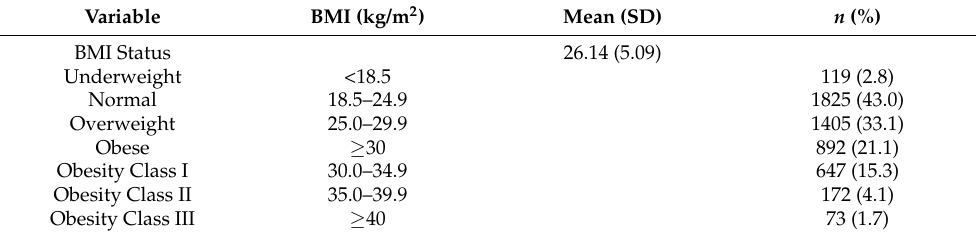
Table 2. BMI status among health-care workers ( n =